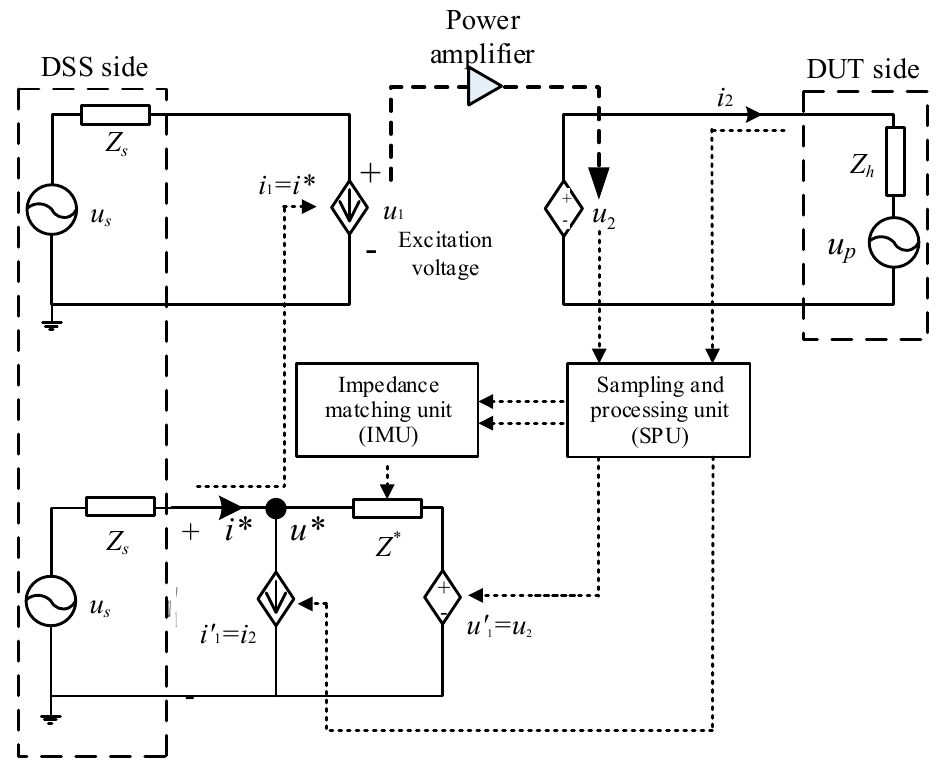
Figure 2. Implementation architecture of the new IA.